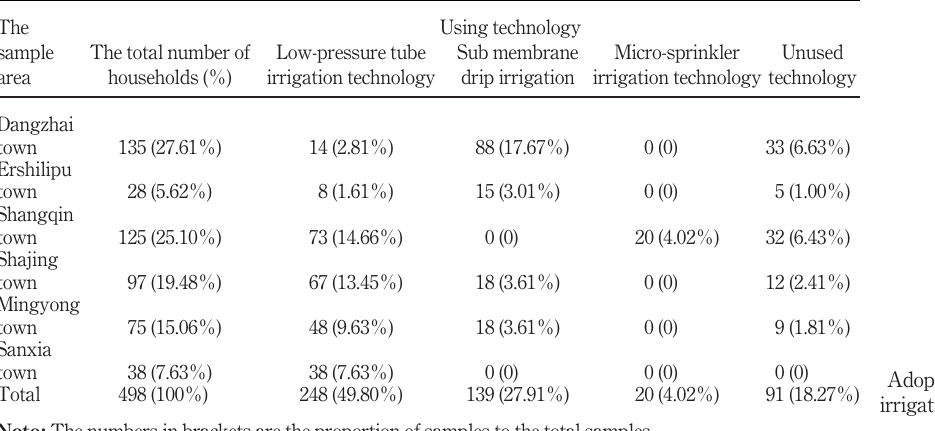
Table 1. Adoption of